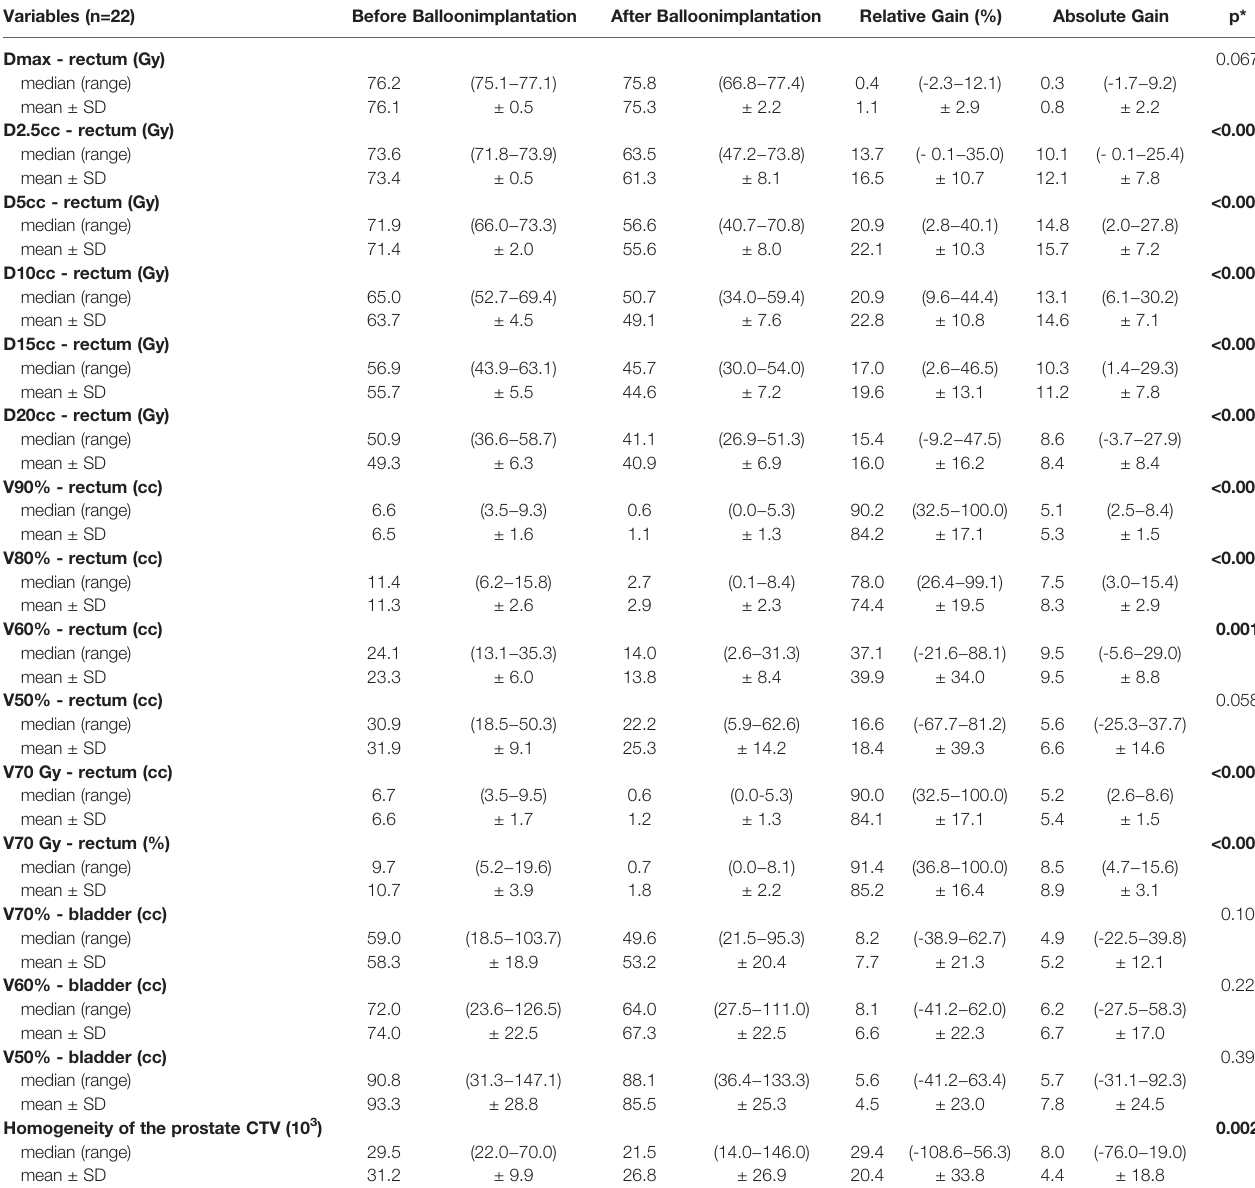
TABLE 3 | Dosimetry parameters before and after ProSpace ® balloon implantation. Variables (n=22) Before Balloonimplantation After Balloonimplantation Relative Gain (%) Absolute Gain Dmax - rectum